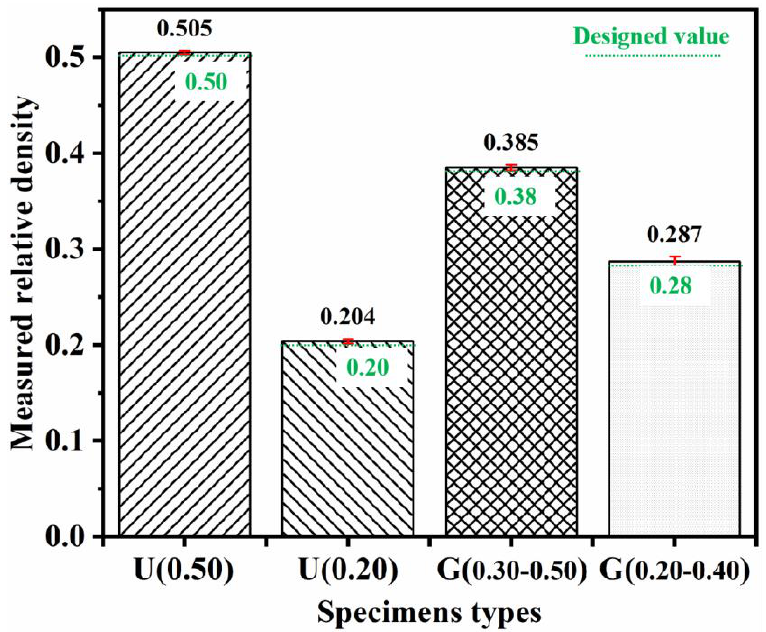
Figure 6. The measured (black) and designed (green) relative densities of lattice structures.